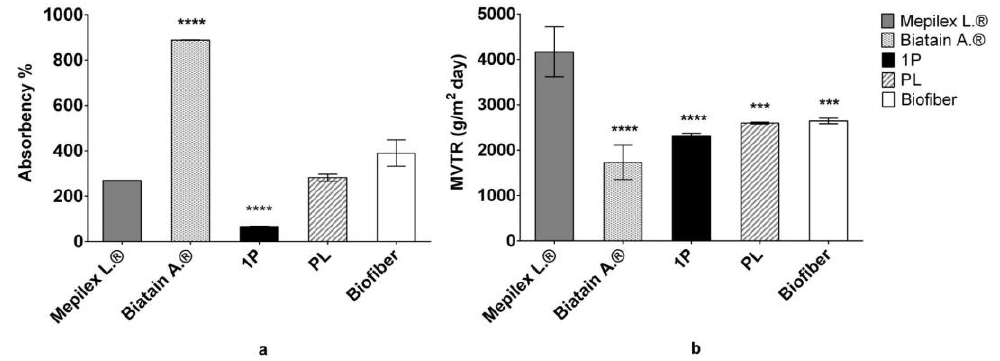
Figure 6. ( a ) Dressing absorption capacity (%), after 24 h of incubation in SWF (34 °C, RH Ambient). ( b ) Moisture vapor transmission rate (MVTR; 34 °C, 11% RH). Analyses were performed comparing placebo (PL) and Biofiber prototypes with no textured electrospun dressing (1P) and commercial controls (Mepilex Lite ® and Biatain ® Alginate). Statistically significant values are indicated as *** p < 0.001, **** p < 0.0001. Two-way ANOVA test was performed to evaluate data